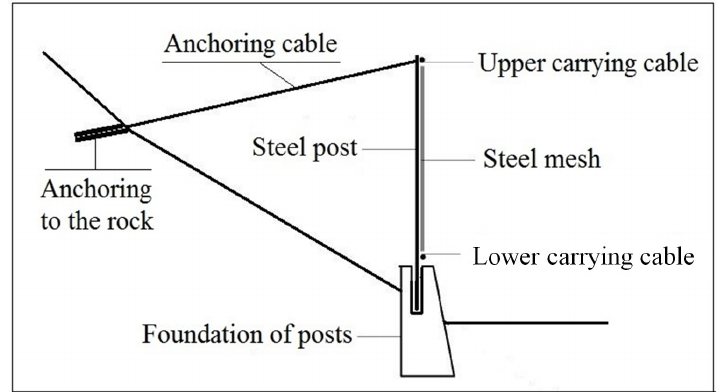
Figure 8. Protective fence – schematic cross